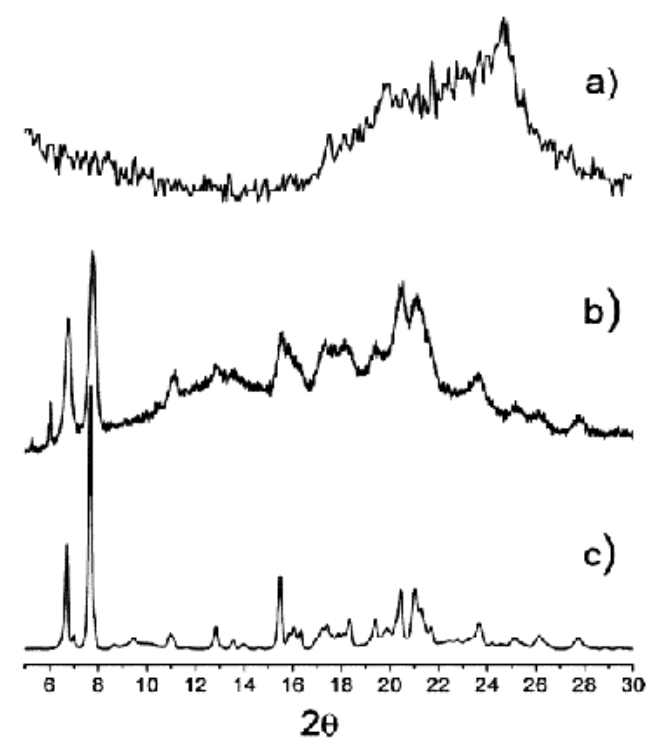
Figure 13. Powder XRD patterns of 2a SLNs: unloaded SLN ( a ); SLNEHMC-1.2 ( b ); and crystalline inclusion complex 2* 2a .1 t -EHMC ( c ) [71].